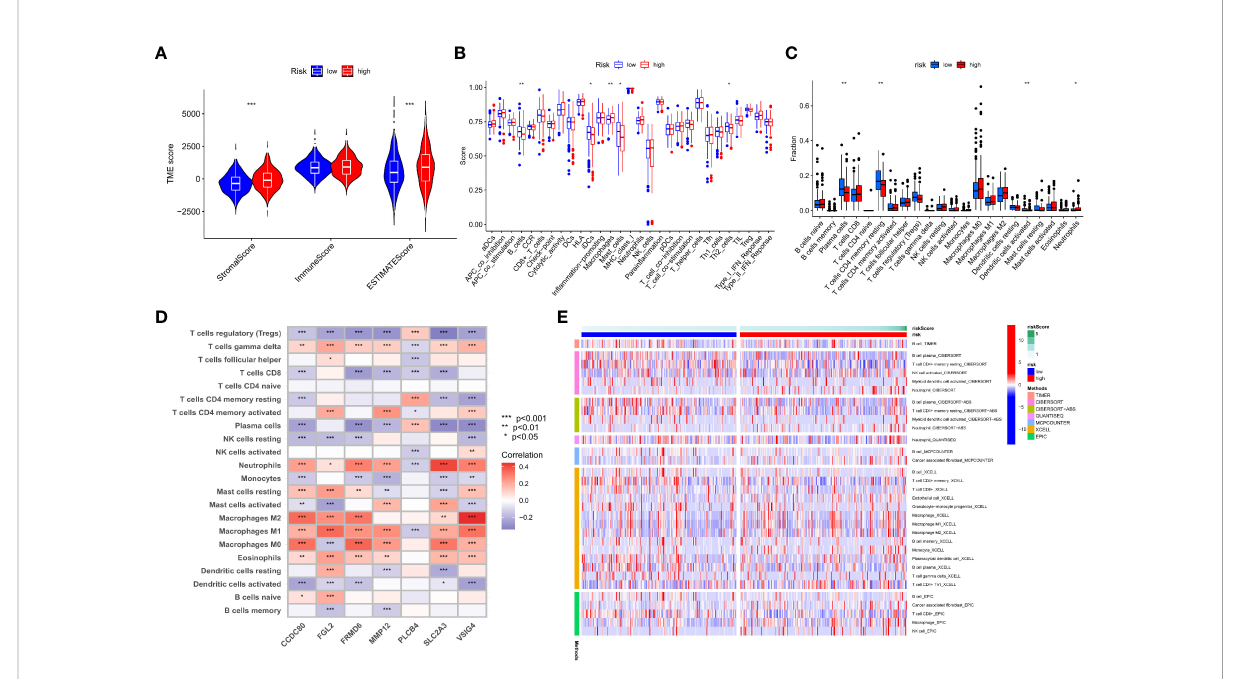
FIGURE 8 An immune landscape analysis based on risk characteristics. (A) The ESTIMATE algorithm evaluates the correlation of different IMRG risk score groups with TME scores; (B) Differential analysis of immune cells and immune function between high- and low-risk groups based on ssGSEA; (C) Differences in immune cell levels between high- and low-risk groups; (D) Correlation between immune cell abundance and the seven genes for constructing the model; (E) Heatmap shows the expression differences of each immune cell in the high- and low-risk groups based on different algorithms; ***p < 0.001; **p < 0.01; *p <